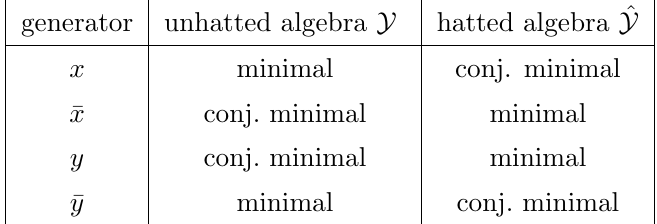
Table 1 . The representation properties of the fermionic